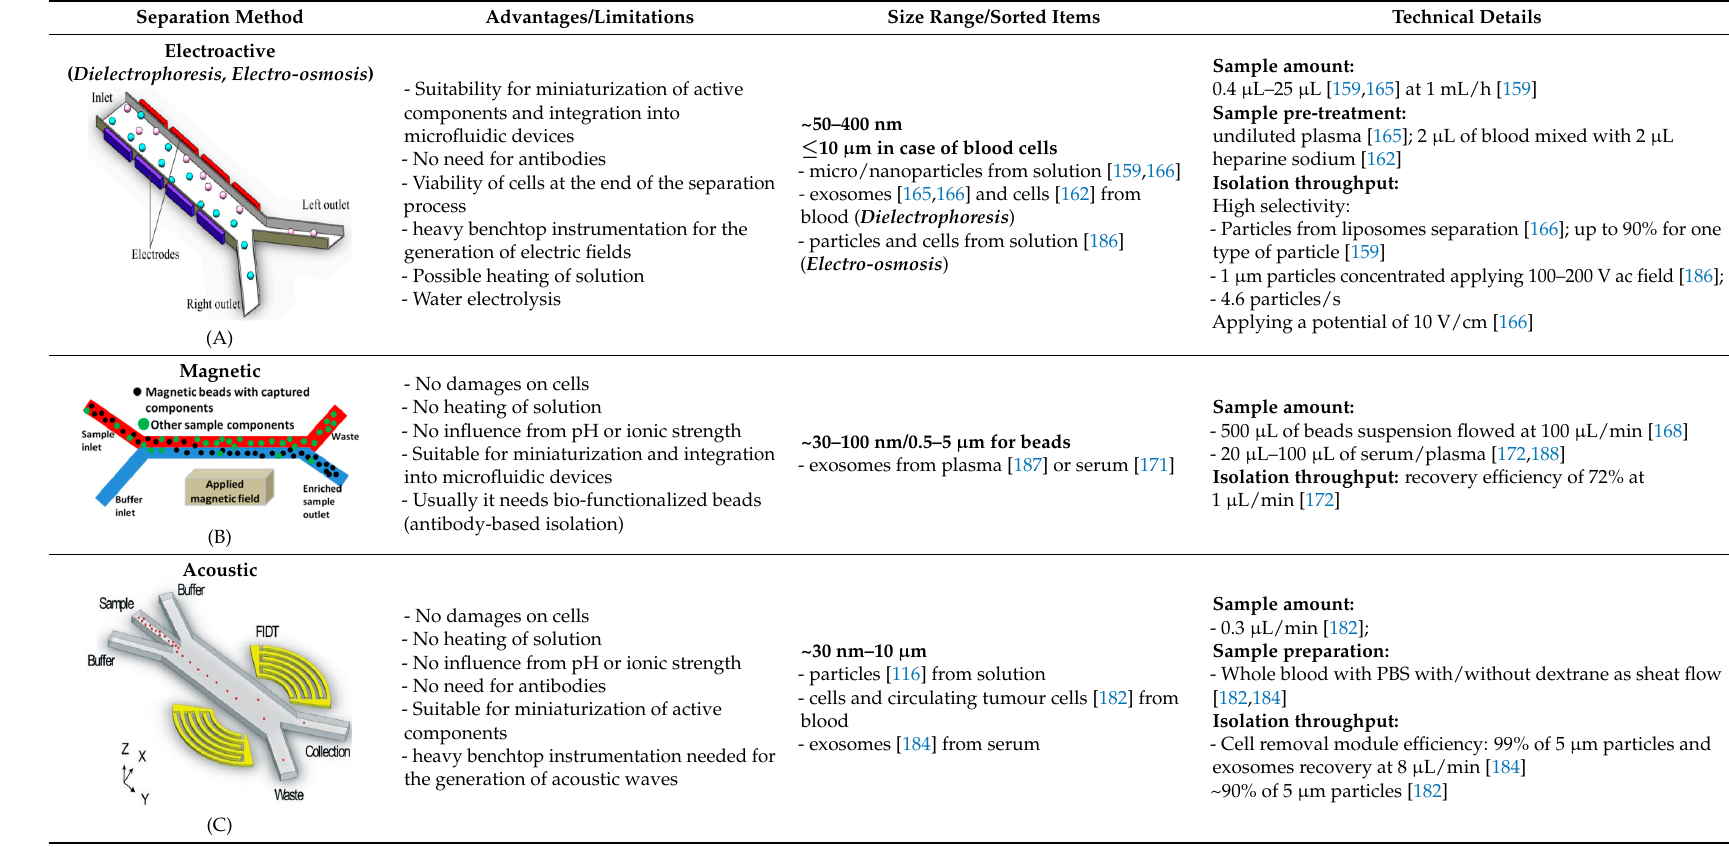
( A ) Scheme of dielectrophoretic separation of particles reproduced from reference [185]; ( B ) Magnetic separation of captured analytes; and, ( C ) Sorting scheme for Surface acoustic waves separation of particles, reproduced with permission from reference